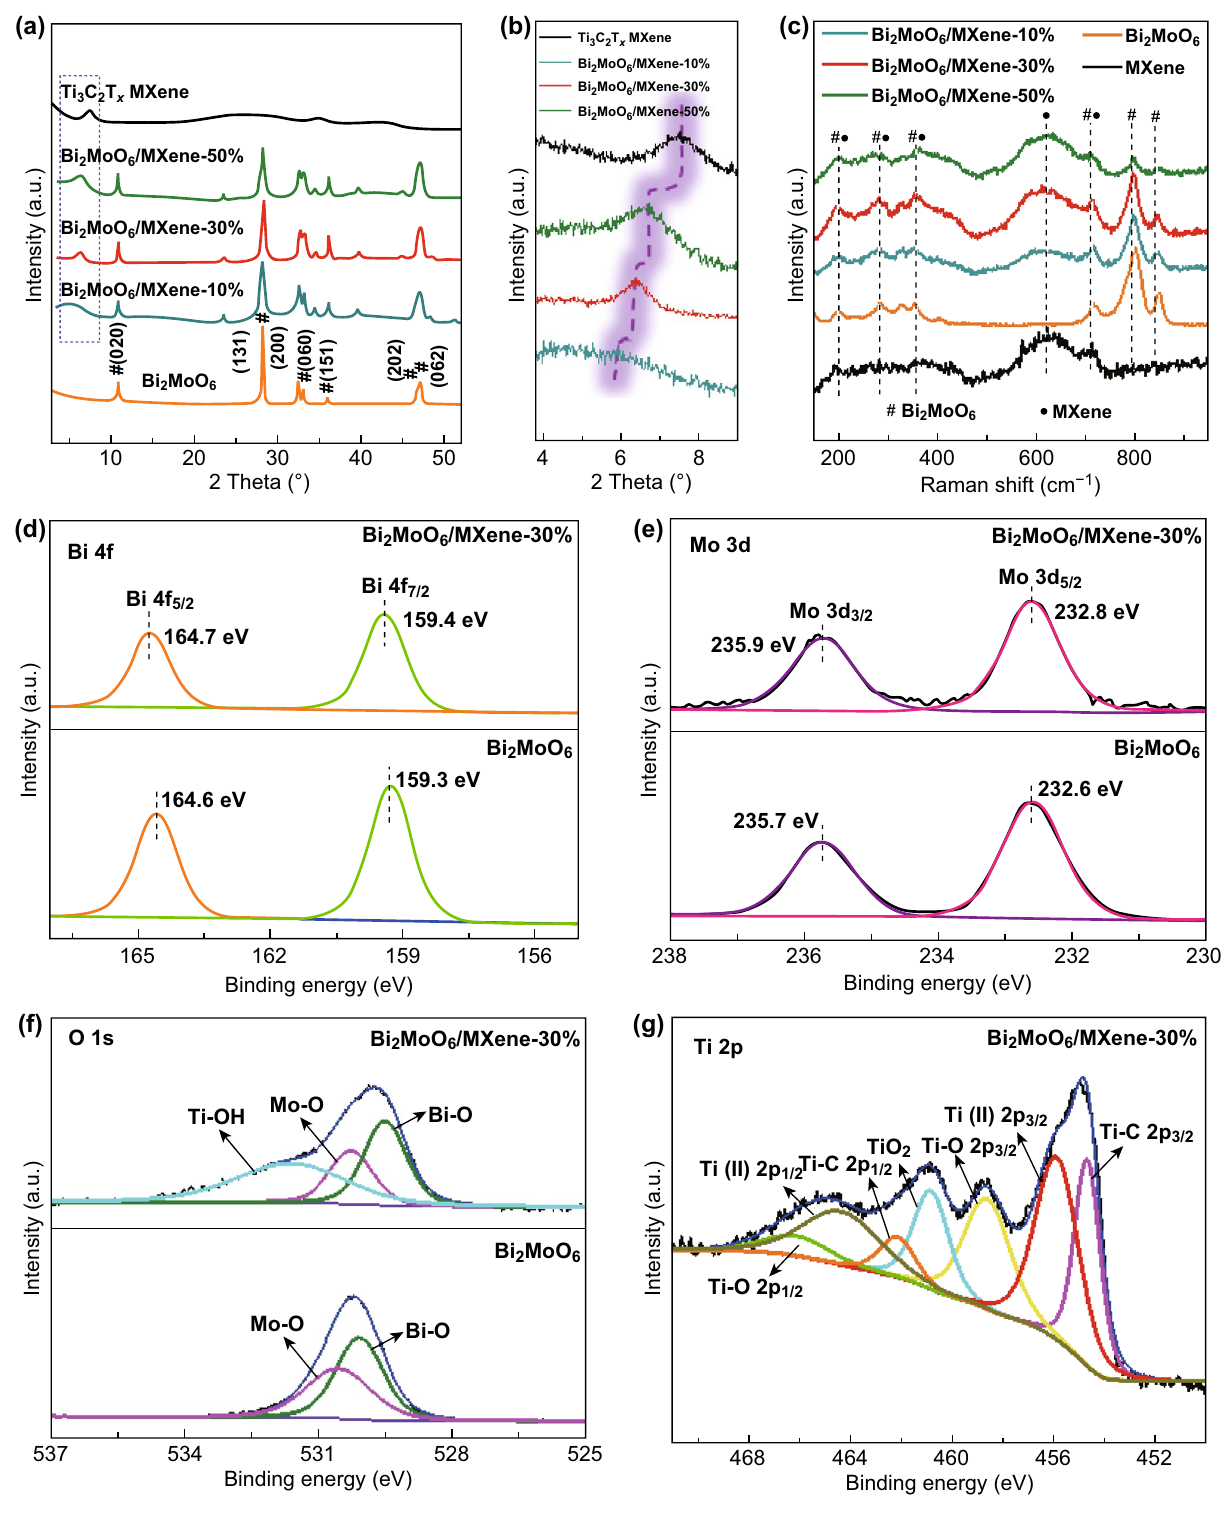
Fig. 4 Characterization of Bi 2 MoO 6 /MXene heterostructures: a , b XRD patterns, c Raman speatra of the Bi 2 MoO 6 /MXene heterostructures. High‑resolution of d Bi 4 f , e Mo 3 d , f O 1 s , and g Ti 2 p XPS spectrum of Bi 2 MoO 6